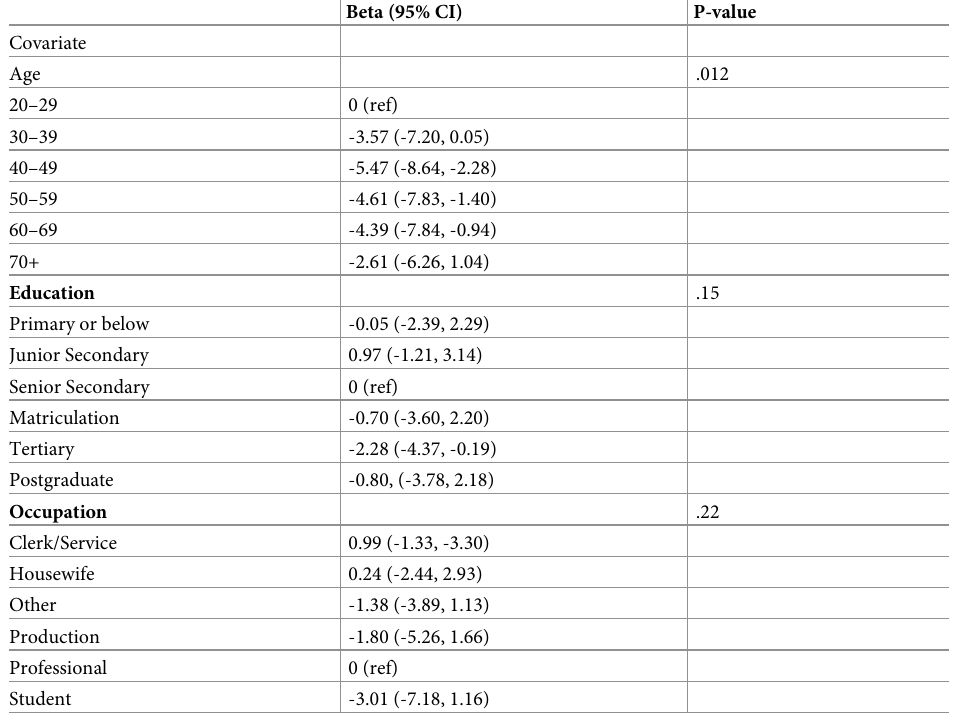
Table 2. Linear regression for amount of aid supported for a disaster relief fund among those who support this